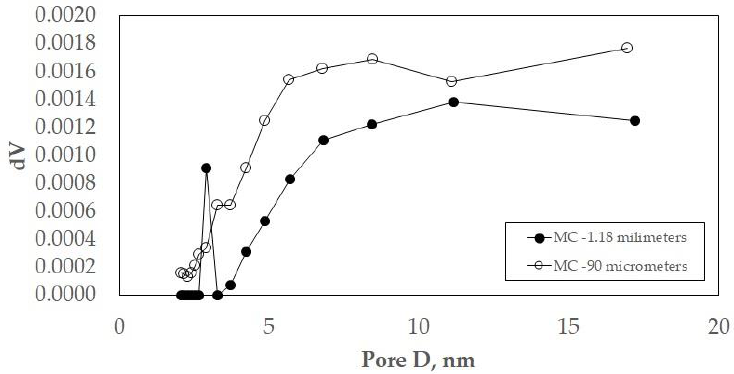
Figure 5. Pore size distribution of the MC sample.